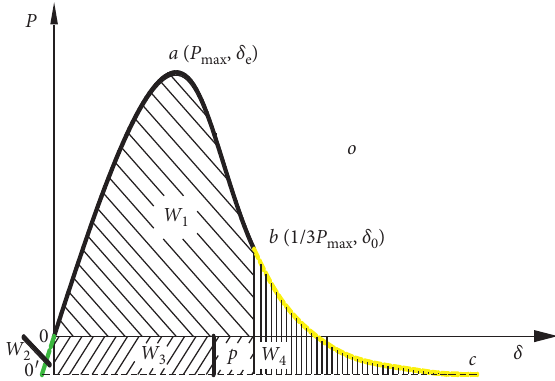
Figure 7: Diagram of fracture energy of concrete.